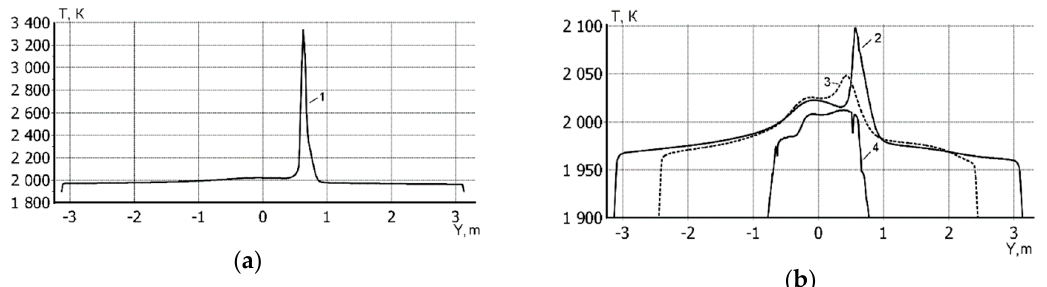
Figure 3. Graphs of the temperature distribution along the Y axis: ( a ) with Z = − 70 mm (1); ( b ) with Z = − 310 mm (2), with Z = − 715 mm (3), and with Z = − 1320 mm (4).